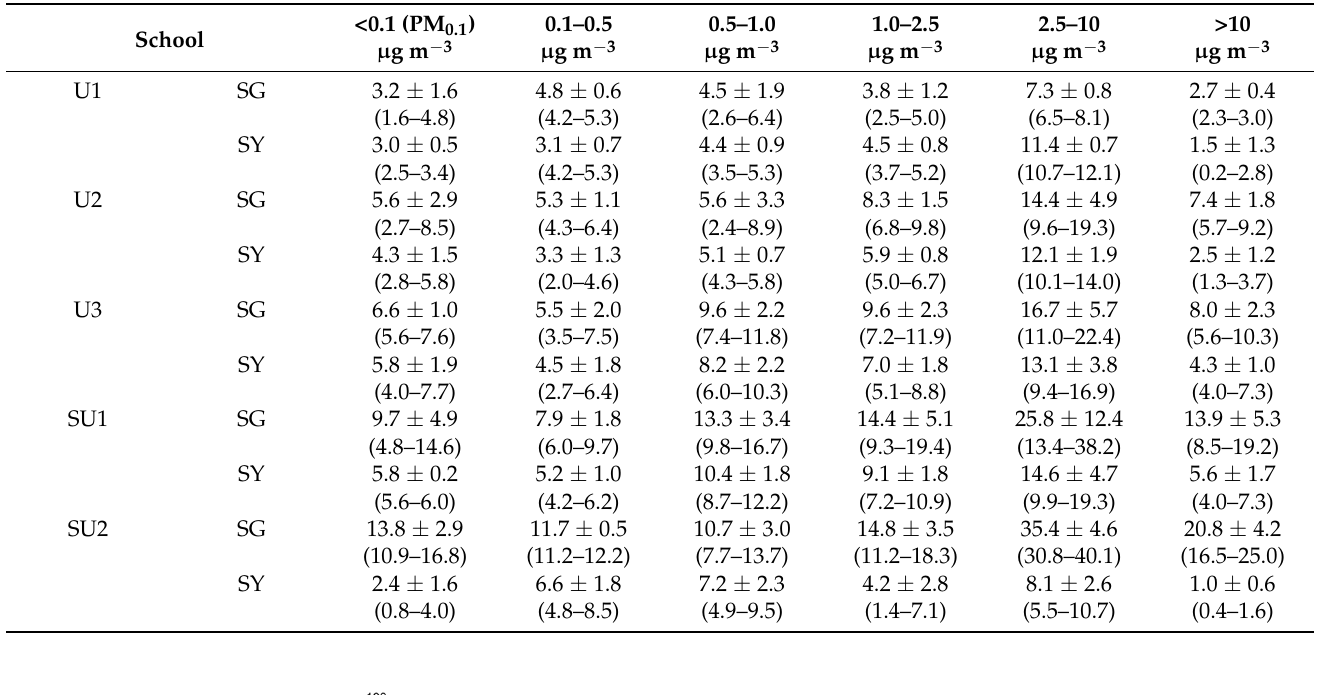
Table 2. Daily mean (standard deviation) and minimum–maximum of mass-size segregated particles at school gate (SG) and schoolyard (SY).